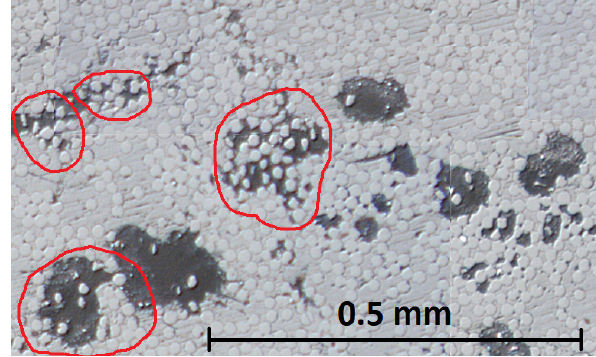
Figure 13: Zoomed area from Figure 12. As can be seen, fiber groups have split from the bulk material and some fibers have completely debonded; here fiber failures can easily interconnect. Red circles highlight the most damaged areas.